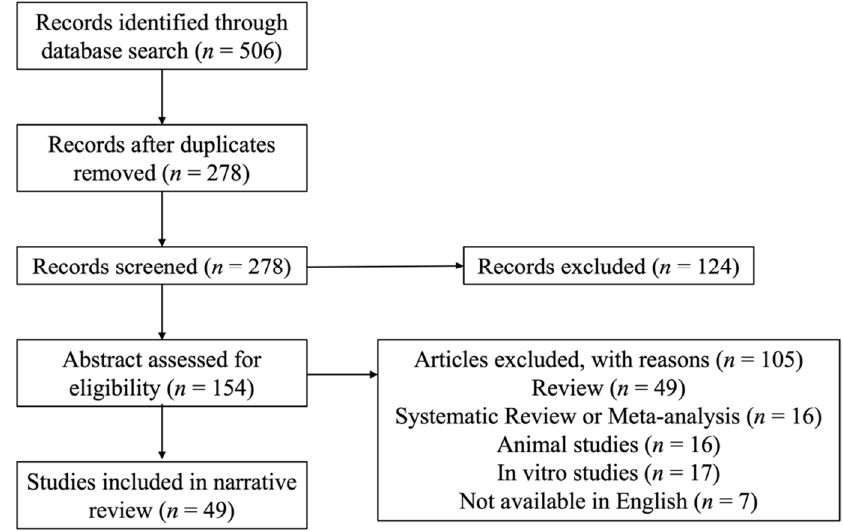
Figure 1. Selection of included studies.